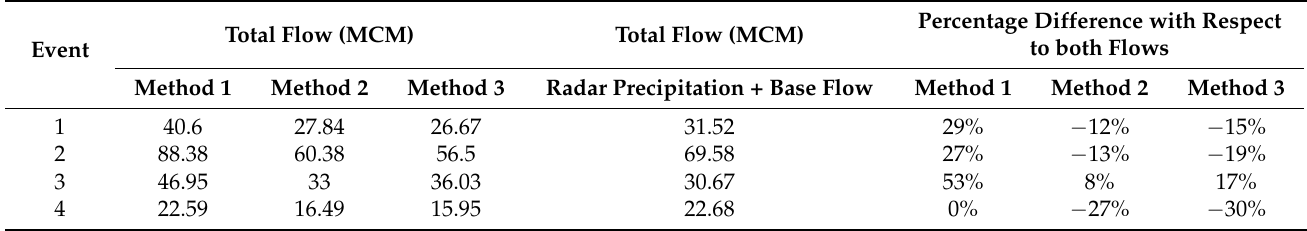
Table 4. Comparison of total calculated flow by different methods with total flow from radar rainfall + base flow for each event of WASH123D (MCM: million cubic meters).